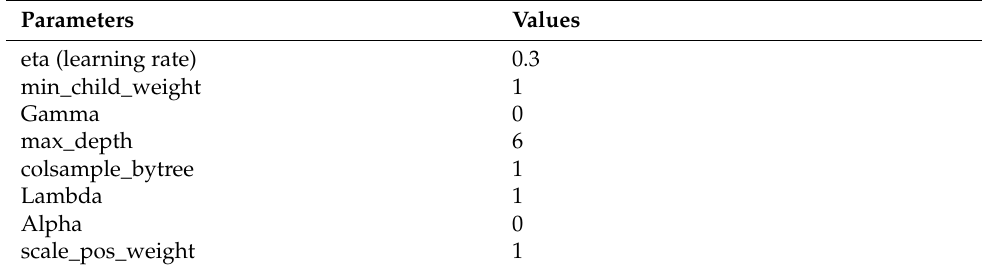
Table 3. Hyperparameters used in the XGBClassifier model and their